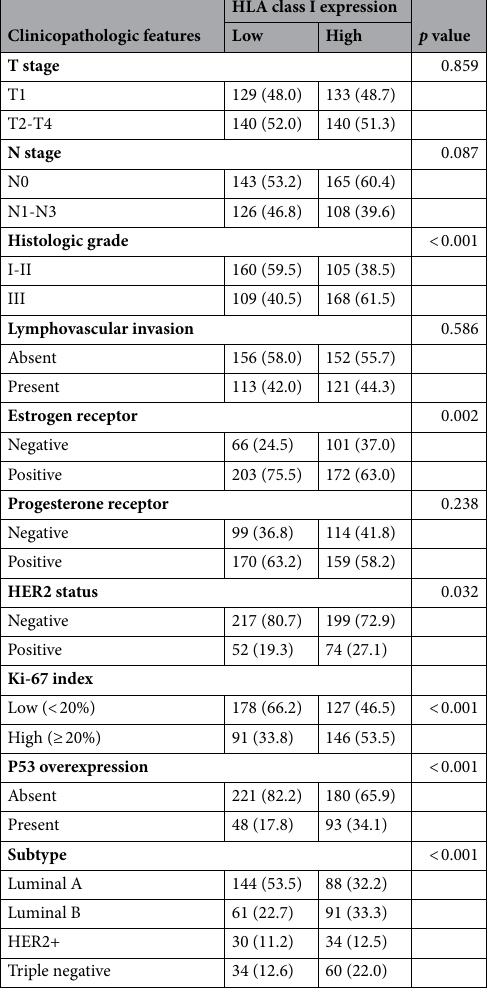
Table 4. Relationship between HLA class I expression level and clinicopathologic features of IBC. p values are calculated by Chi-square test. HLA human leukocyte antigen, IBC invasive breast